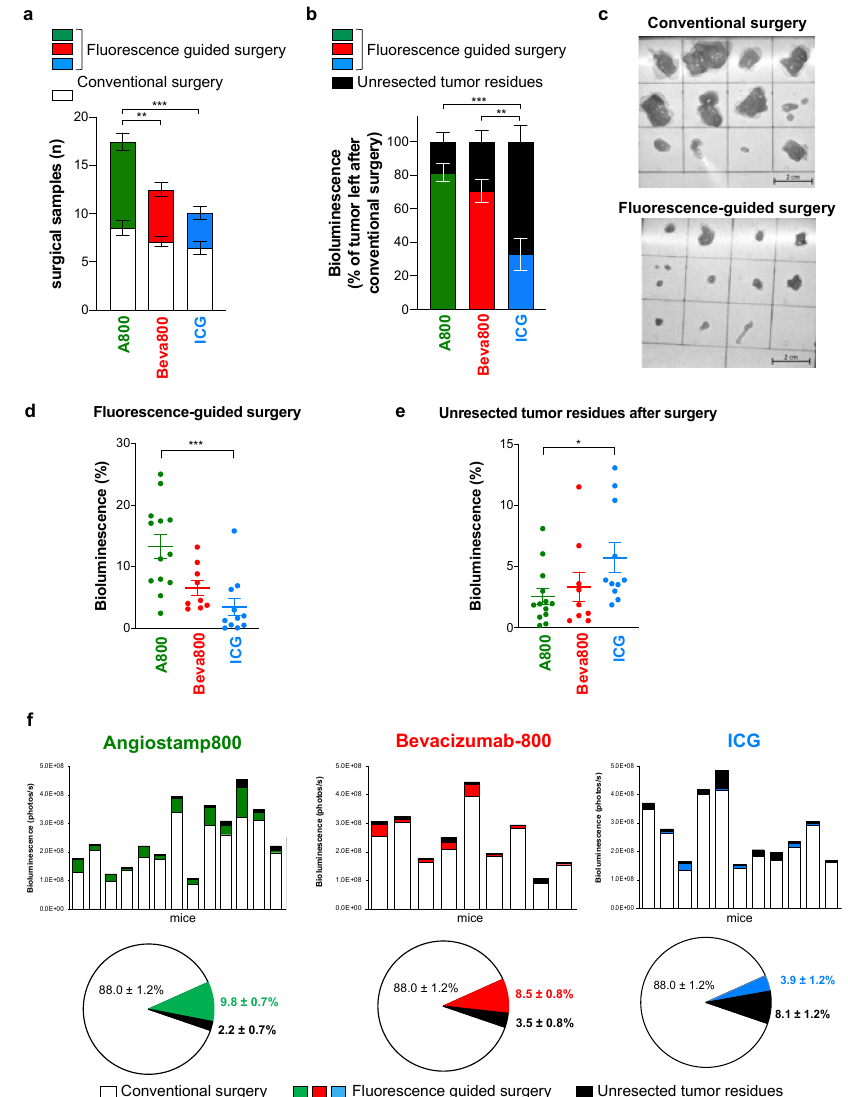
Figure 2. Angiostamp800 and Bevacizumab-IRDye 800CW improved fluorescence-guided surgery for peritoneal carcinomatosis. ( a ): Mean number of tumor nodules resected by conventional and fluorescence-guided surgery. ** p = 0.004; *** p < 0.001; two-way ANOVA with Tukey post-hoc tests. ( b ): Bioluminescence of tumor resected by fluorescence-guided surgery and of unresected tumor residues expressed as a percentage of tumor left after conventional surgery (mean ± SEM). ** p = 0.003; *** p < 0.001; two-way ANOVA with Tukey post-hoc tests. ( c ): Representative images of nodules resected by conventional and fluorescence-guided surgery. Scale bar = 2 cm. ( d ): Bioluminescence signals of tumor nodules resected by fluorescence-guided surgery expressed as the percentage of total tumor burden in mice. *** p < 0.001; Kruskal–Wallis test with Dunn’s multiple comparisons post-hoc tests. ( e ): Bioluminescence signals of unresected tumor residues after the 2-steps surgery, expressed as the percentage of total tumor burden in mice. * p = 0.04; Kruskal–Wallis test with Dunn’s multiple comparison post-hoc tests. ( d , e ): Each dot represents one mouse. Bars, mean ± SEM. ( f ): Histograms show bioluminescence signals of tumor nodules resected by conventional surgery, fluorescence-guided surgery, and unresected tumor residues in each mouse. Pies show bioluminescence of tumor nodules resected by conventional surgery, fluorescence-guided surgery, and unresected tumor residues (false-negative fluorescent signal) in every mouse and expressed as the percentage of total tumor burden (mean ±